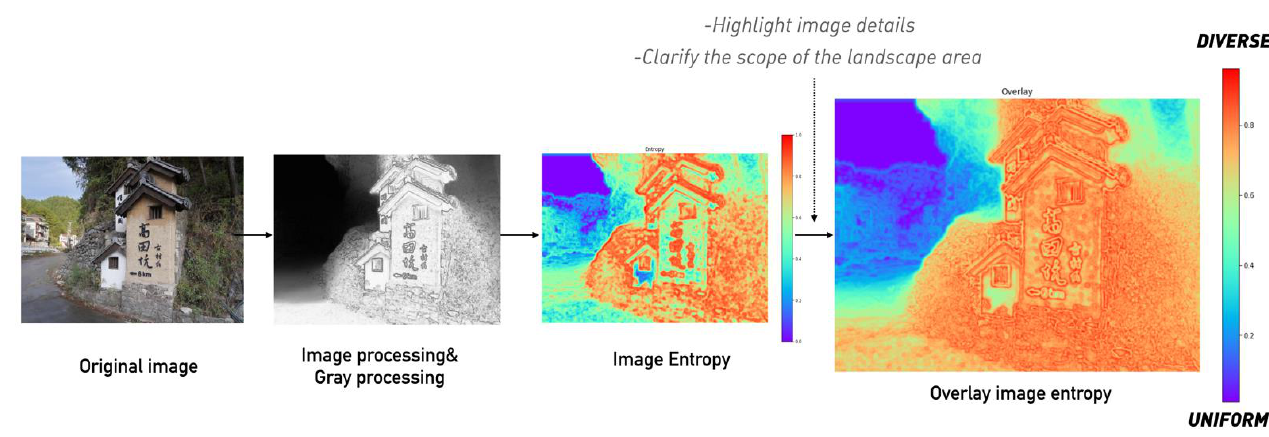
Figure 4. Flow table of the entropy image framework.